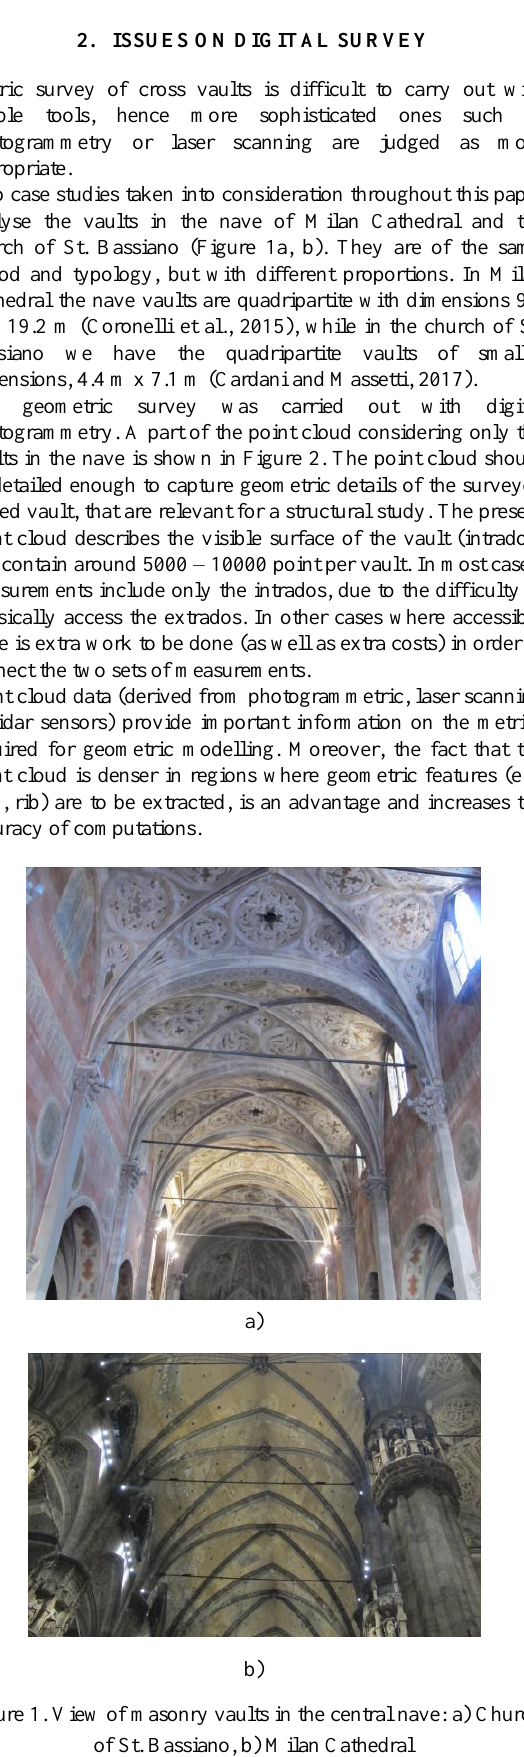
Figure 3. Milan Cathedral: Point cloud of the vaults in the